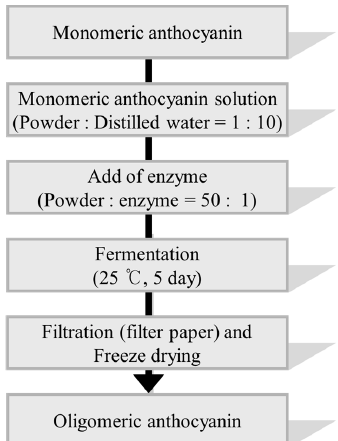
Figure 8. The flow chart for the synthesis of oligomeric anthocyanins using glucosidase from Aspergillus niger .